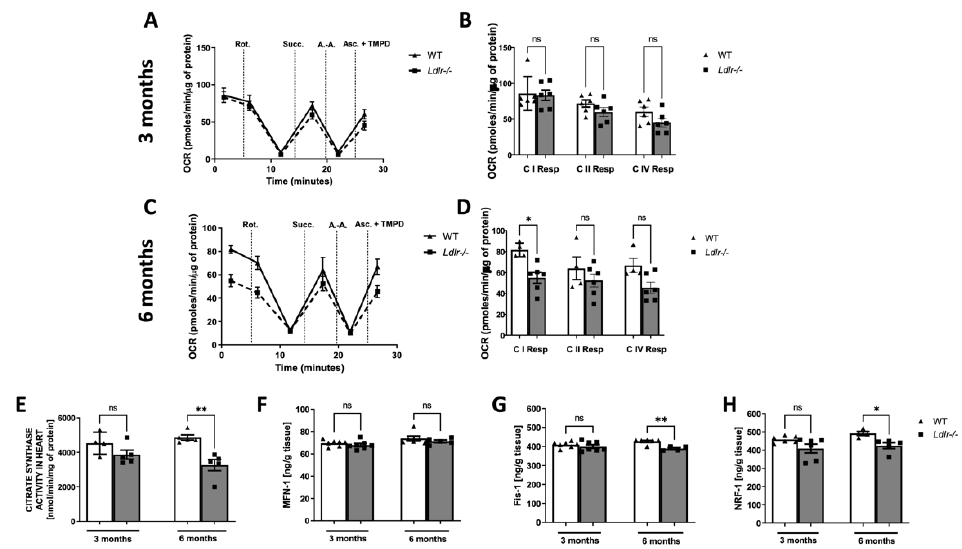
Figure 1. Altered cardiac mitochondria function in a mouse model of dyslipidemia ( Ldlr−/− ). Oxygen consumption rate (OCR) after sequential injection of rotenone (Rot.), succinate (Succ.), antimycin (A.-A.), and ascorbate with tetamethylphenylenediamine (Asc.+TMPD) in isolated cardiac mitochondria of 3-month-old wild-type (WT) and dyslipidemic mice ( Ldlr−/− ) ( A ). The activity of mitochondrial respiratory chain complexes (C) in cardiac mitochondria of 3-month-old WT and Ldlr−/− mice ( B ). OCR after sequential injection of Rot., Succ., A.-A., and Asc.+TMPD in isolated cardiac mitochondria of 6-month-old WT and Ldlr−/− mice ( C ). The activity of mitochondrial respiratory chain complexes (C) in cardiac mitochondria of 6-month-old WT and Ldlr−/− mice ( D ). Complex I and IV respiration (C I Resp, C IV Resp) were calculated as the resulting OCR after subtraction of rotenone or antimycin a driven respiration, respectively. Complex II Respiration (C II Resp) was measured as the succinate-driven OCR. The activity of citrate synthase in the heart of WT and Ldlr−/− mice ( E ), and the level of proteins involved in mitochondrial fusion, fission, and mitochondrial biogenesis: mitofusin 1 (MFN-1), mitochondrial fission 1 protein (Fis1), and nuclear respiratory factor 1 (NRF-1) ( F – H ), n = 4–7; * p < 0.05; ** p < 0.01 ; ns, non-significant.